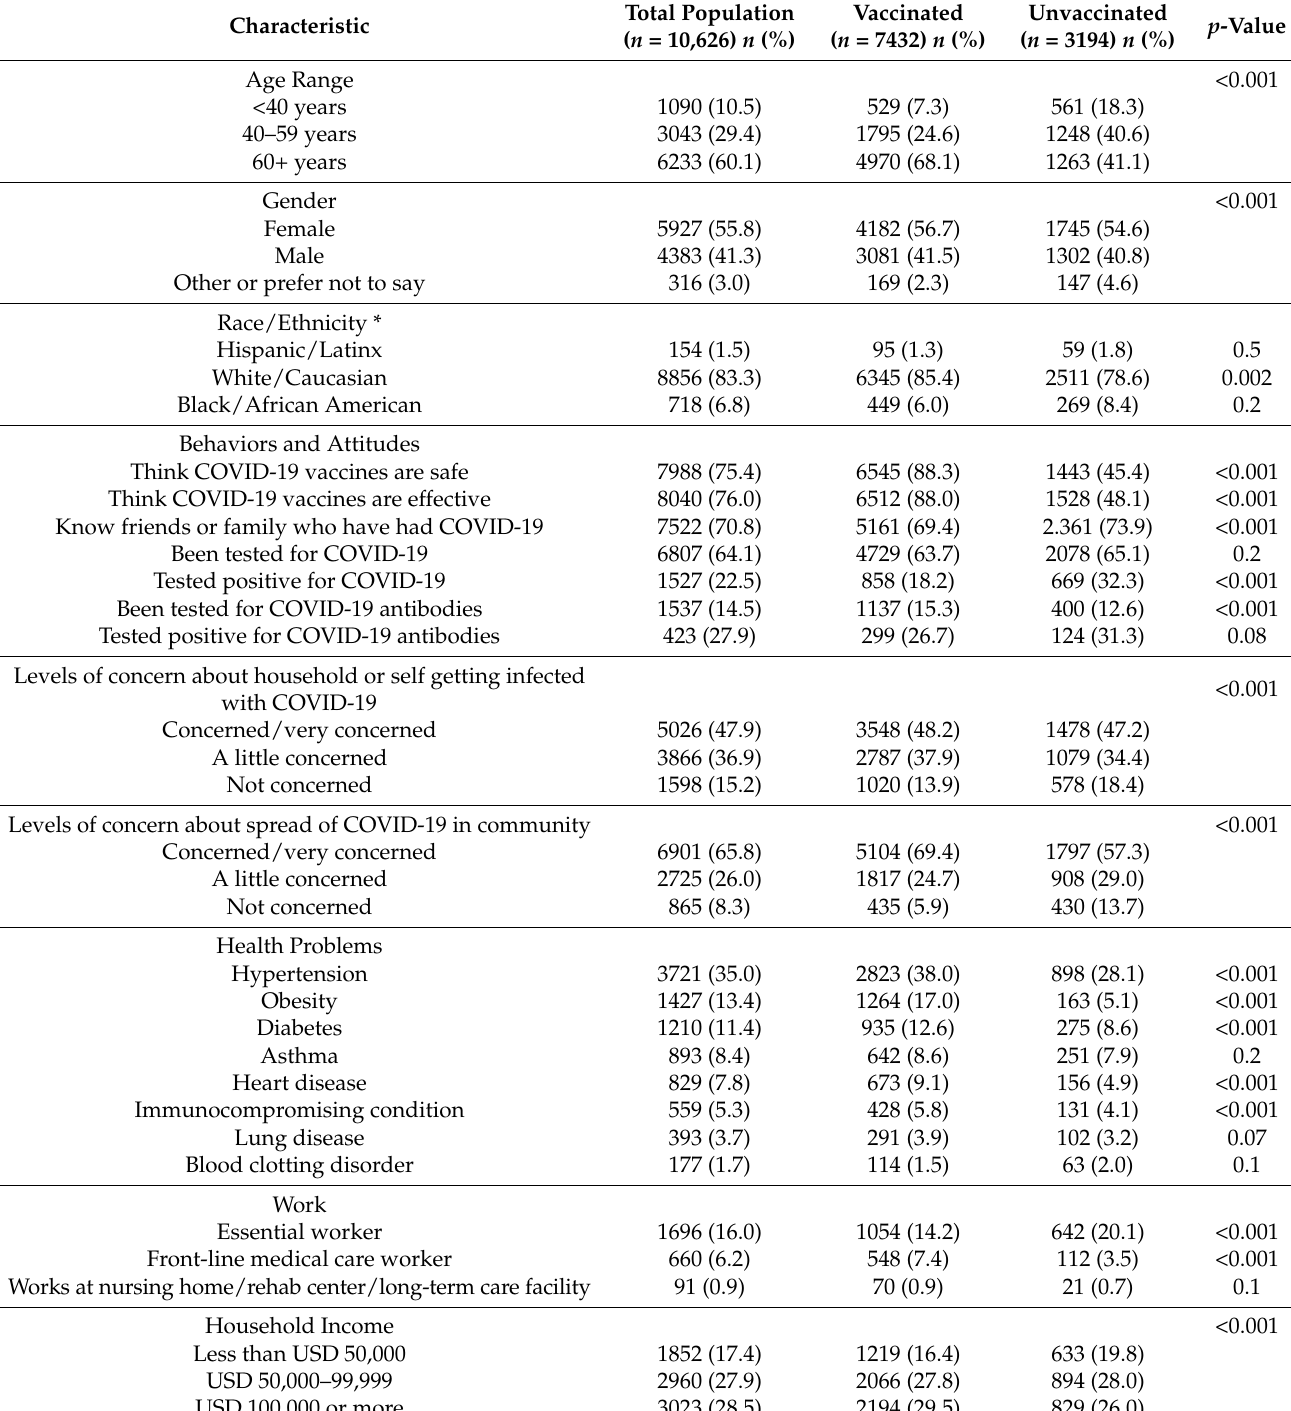
Table 1. Characteristics of participants in South Carolina, categorized by vaccination